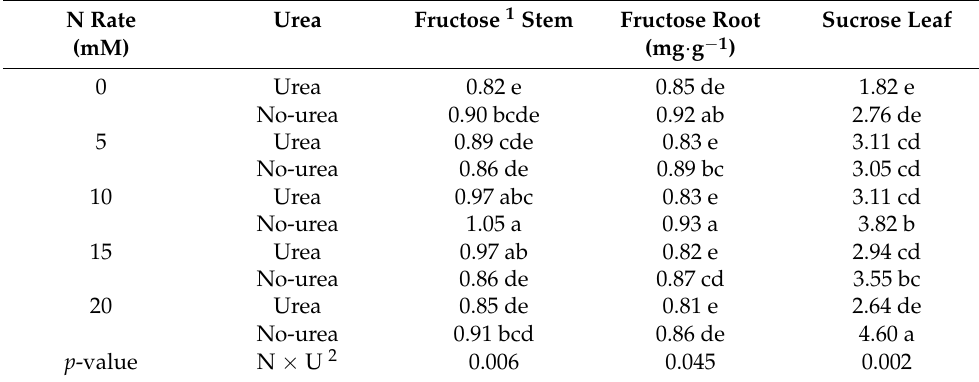
Table 7. Carbohydrate concentrations in Encore ® azalea ‘Chiffon’ affected by the N rate and foliar urea application